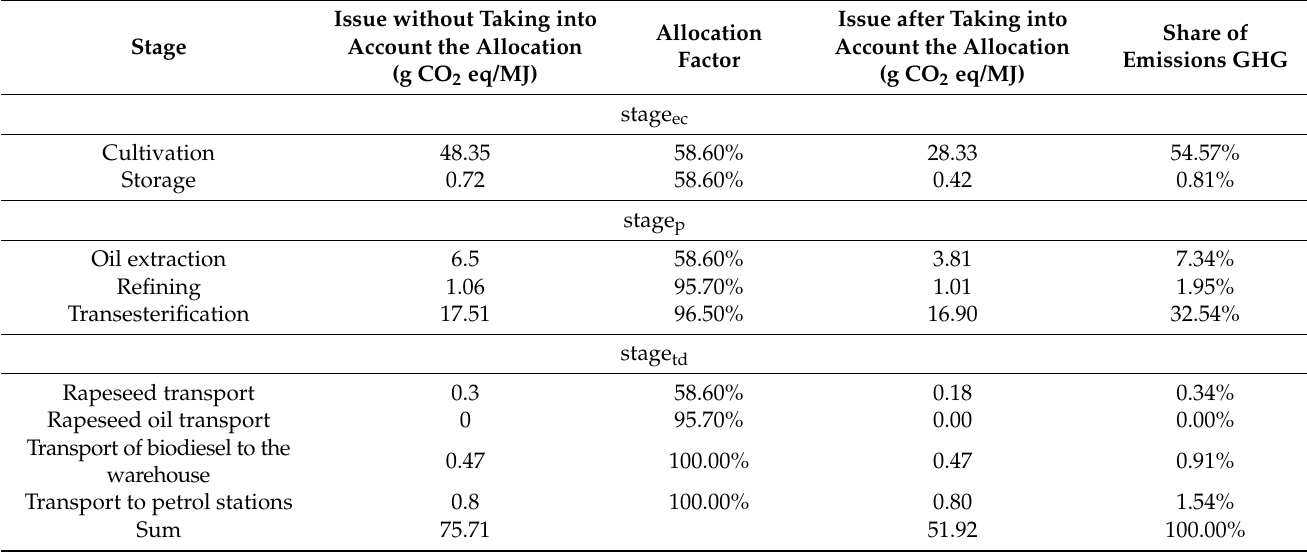
Table 15. GHG emissions in the biofuel life cycle based on mass share.